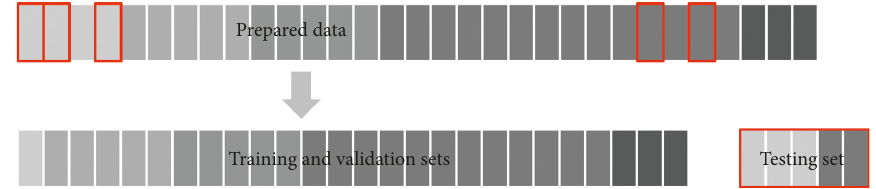
Figure 17: Samples of 5 randomly chosen videos were used for testing, while others served as the training and validation sets.